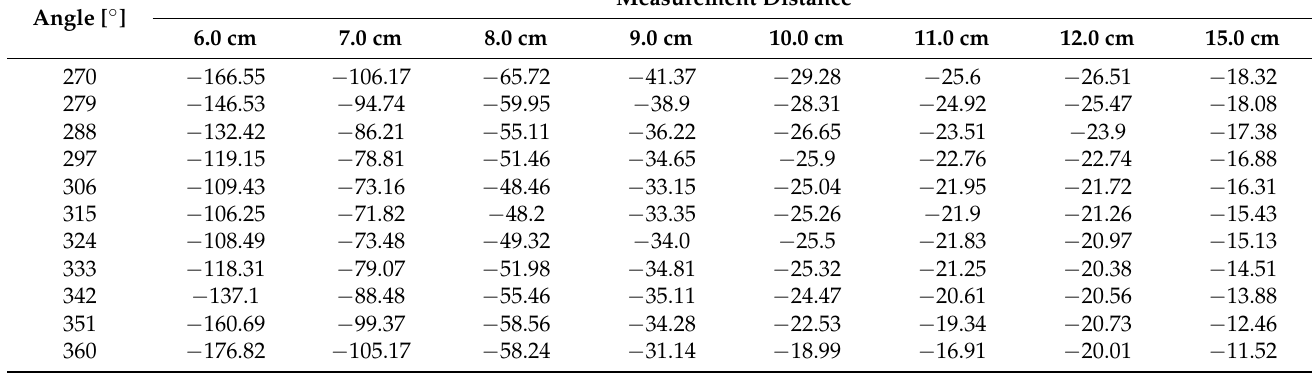
Table 8. Estimated values of the B y component of magnetic induction as a function of rotation angle and measurement